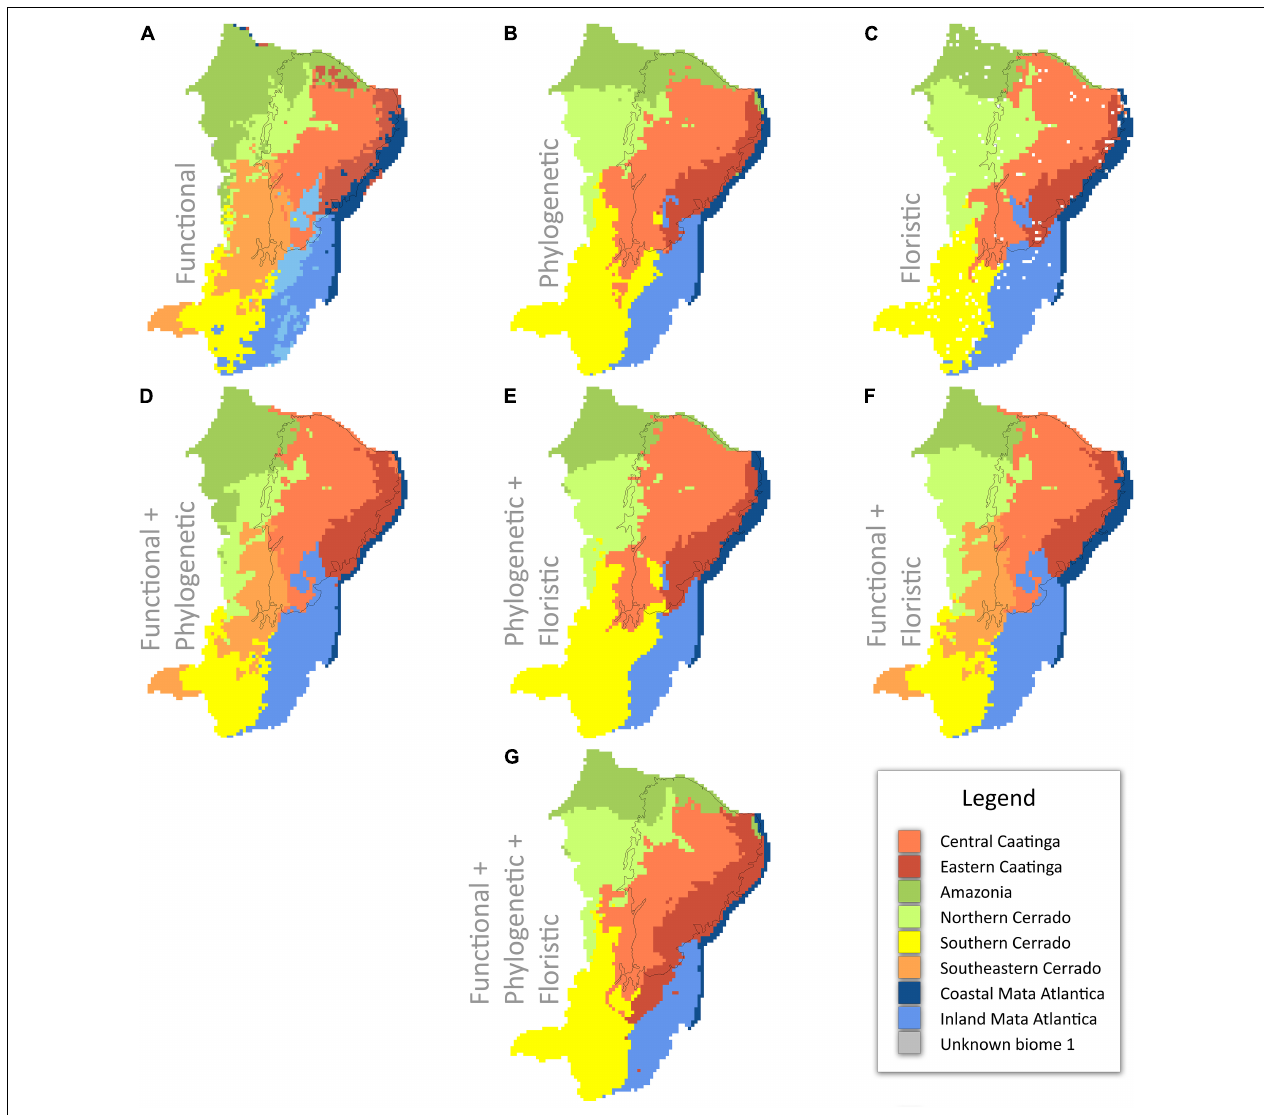
FIGURE 2 | Cluster classifications across northeast Brazil based upon hierarchical clustering analyses of functional, phylogenetic, and floristic data alone (A–C) and in combination (D–F) : (A) functional data; (B) phylogenetic data; (C) floristic data; (D) functional and phylogenetic data; (E) phylogenetic and floristic data; (F) functional and floristic data; and (G) functional, phylogenetic, and floristic data. The black line indicates the limits of the Caatinga domain sensu Instituto Brasileiro de Geografia e Estatística (IBGE)